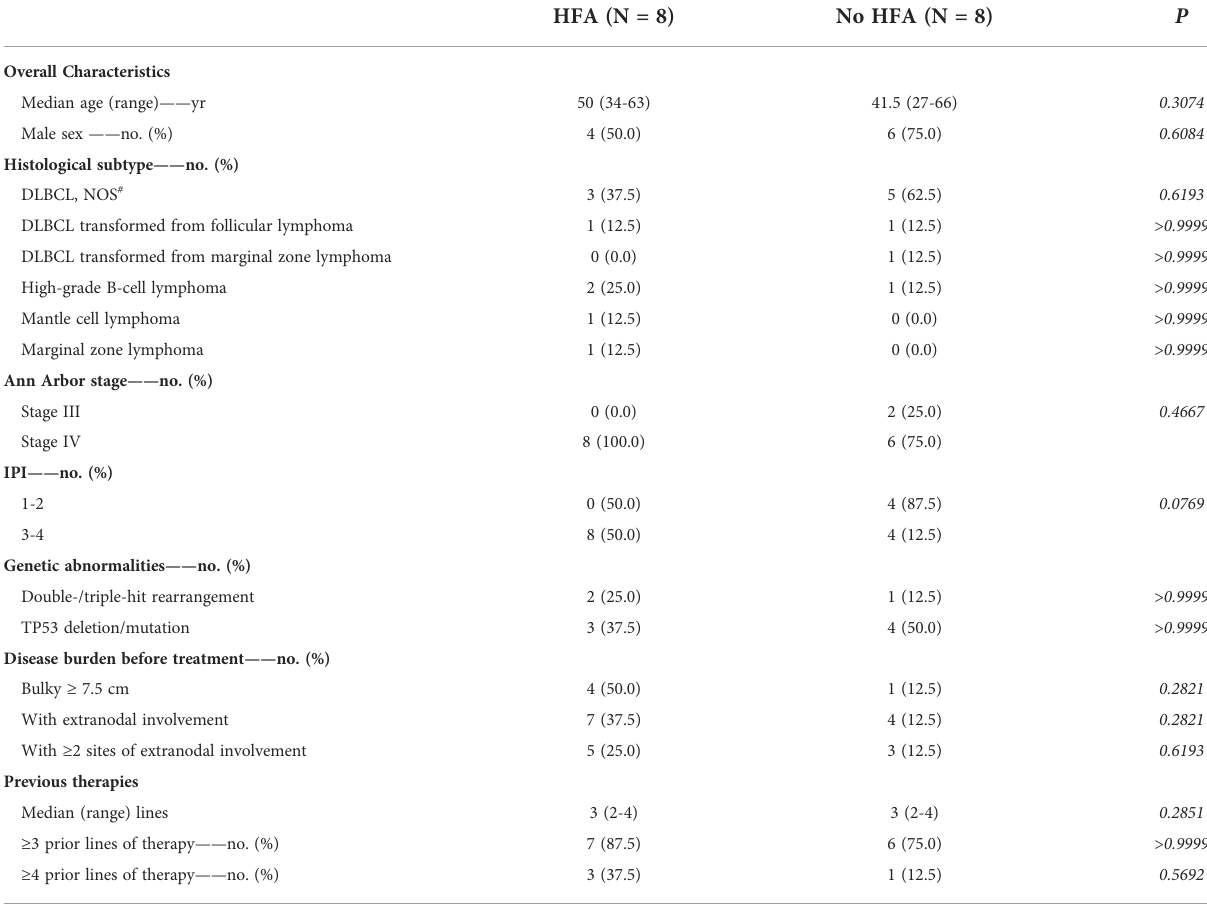
TABLE 1 Clinical characteristics of B-cell lymphoma